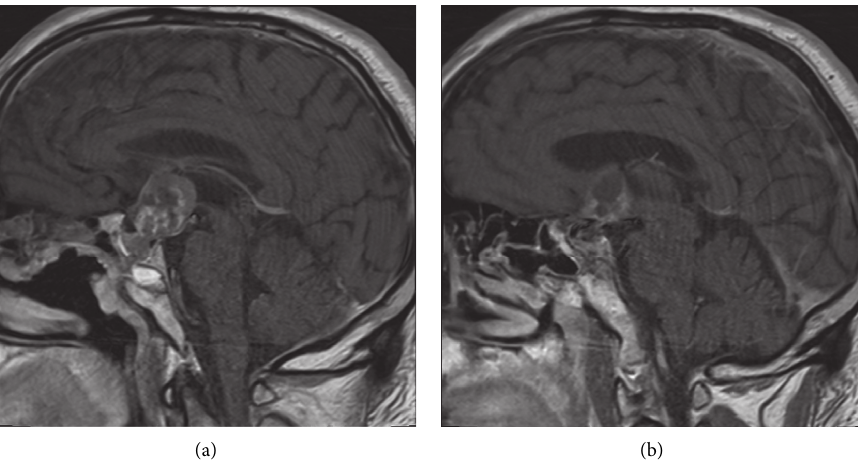
Figure 1: Initial MRI without gadolinium ordered by primary care provider, revealing a suprasellar mass extending into the anterior portion of the third ventricle and displacing the hypothalamus. There is evidence of a robust septal flap and residual fat graft from prior resection.